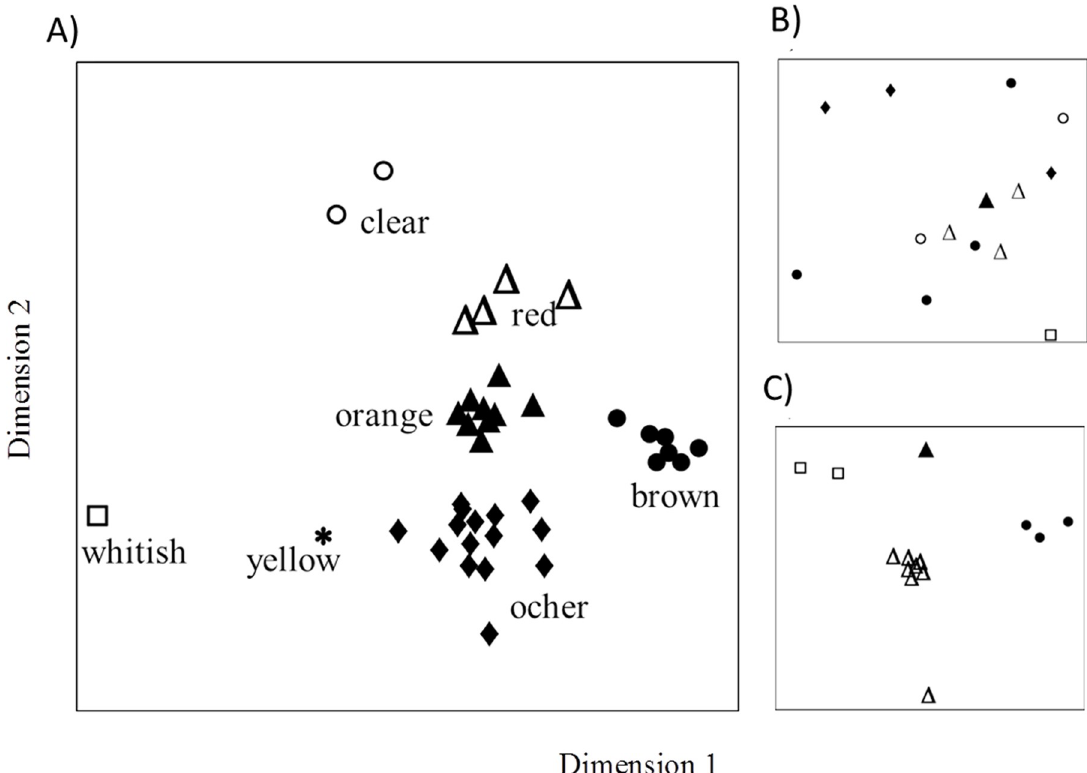
Fig 4. Chemical similarity within bee-collected resin samples. Chemical similarity of A) all resin samples collected by returning resin foragers (n = 39), B) only “ocher” samples (n = 14) and C) only “orange” and “red” samples (n = 15); ordination Figure from non- metrical three-dimensional scaling (NMDS) based on Bray-Curtis dissimilarities (stress value = 0.15). Different symbols represent different resin types (closed circle, “brown”; closed diamond, “ocher”; closed triangle, “orange”; open triangle, “red”; star, “yellow”; open circle, “clear”; open square, “whitish”) in A) and different sampling sites (closed circle, “Ez”; closed diamond, “Et”; closed triangle, “Lg”; open triangle, “Gr”; open circle, “Ml”; open square, “Ol”; for meaning of abbreviations see Table 1) in B) and